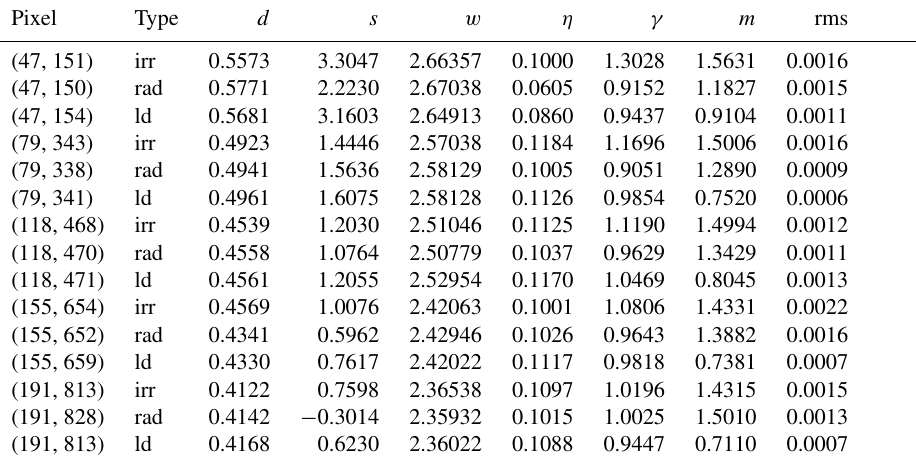
Table 2. Listing of ISRF parameters (Eq. 13) of five typical SWIR ISRFs determined from irradiance (irr), radiance (rad) and diode-laser (ld) measurements, respectively. The location of the ISRF are (approximately) equally spaced at positions on the SWIR detector from top left to bottom